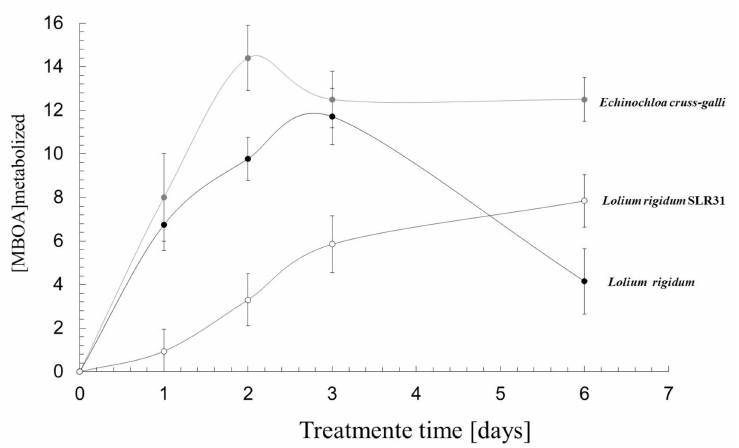
Figure 6. Metabolized MBOA levels calculated by eq.1 for Echinochloa crus-galli and Lolium rigidum (wild and SLR31), according to time of treatment with a concentration of 3 mM MBOA. The error bars represent standard deviation for n =